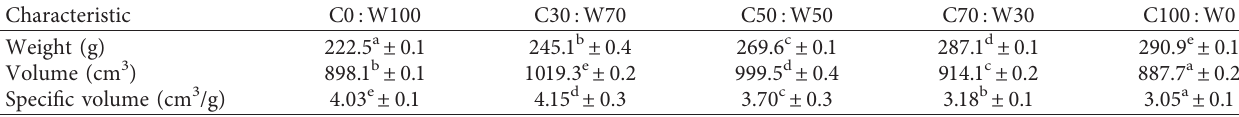
Mean ± standard deviation ( n � 3). Different letters in the same row represent significant differences between samples ( P ≤ 0 . 05). C0:W100: 100% water (control), C30:W70: 70% water and 30% camel milk, C50:W50: 50% water and 50% camel milk, C70:W30: 30% water and 70% camel milk, and C100:W0: 100% camel milk.